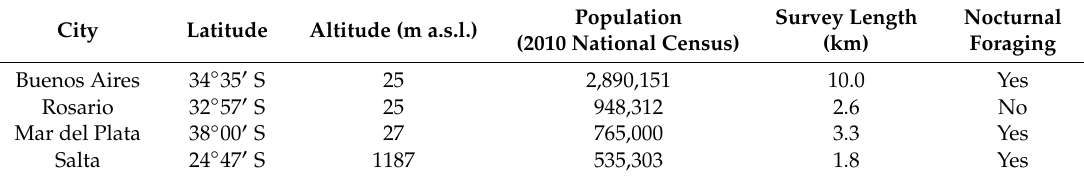
Table 1. Characteristics of cities surveyed and occurrence of nocturnal foraging by Feral Pigeons ( Columba livia f. domestica ) in the most highly urbanized areas of four medium-sized and big cities of